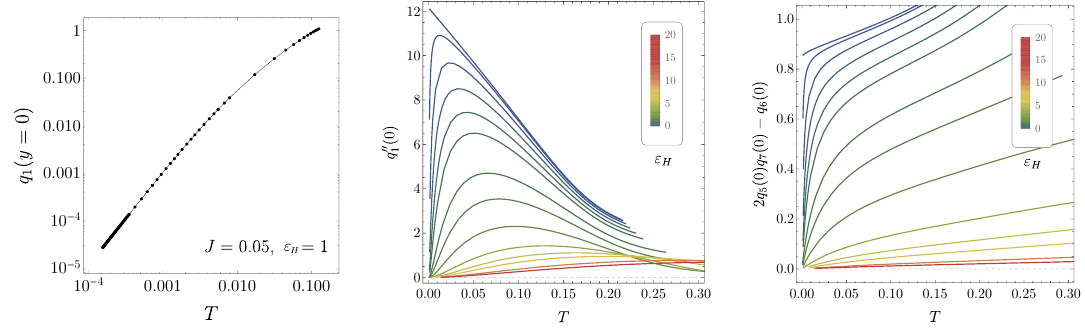
Figure 9 . The value of q 1 at the horizon y = 0 against the temperature, for a black hole family with J = 0 : 05 and " H = 1. Middle : the value of q 00 against T , for several values of " H . Right : the value 1 of 2 q 5 q 7 (cid:0) q 6 at the horizon against the temperature, for several values of the horizon scalar